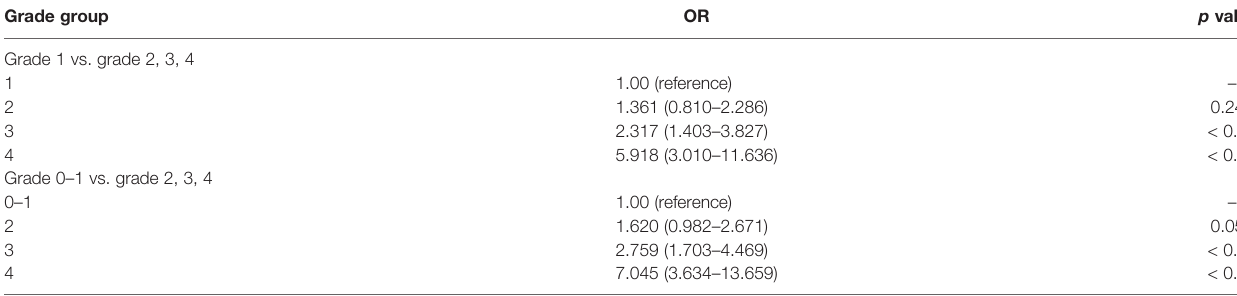
TABLE 8 | Differences of odds ratios between grade 1 and grades 2, 3, 4, as well as between grades 0 – 1 and grades 2, 3, 4. Grade group OR p value